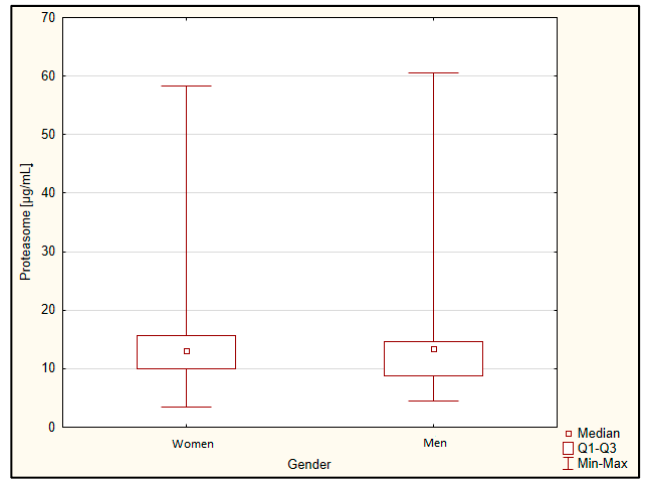
Figure 3. Concentration of proteasome depending on gender. Q1, lower quartile; Q3, upper quartile.